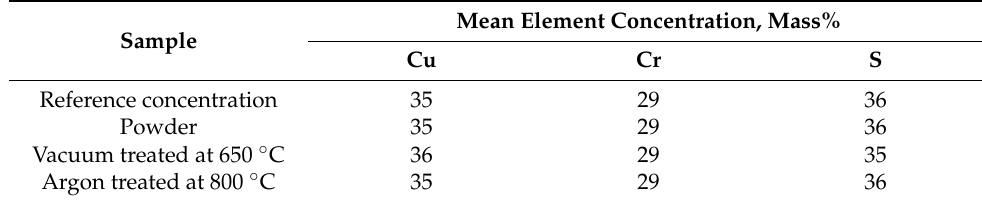
Table 1. Sample treatment conditions.